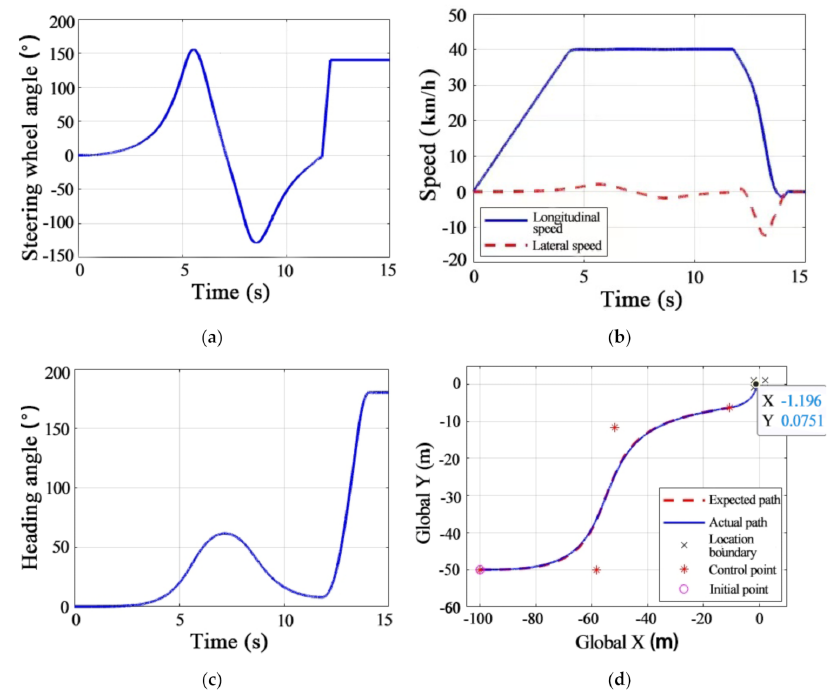
Figure 4. Simulation test results: ( a ) Steering wheel angle; ( b ) Vehicle speed; ( c ) Heading angle; and ( d ) Drift process.